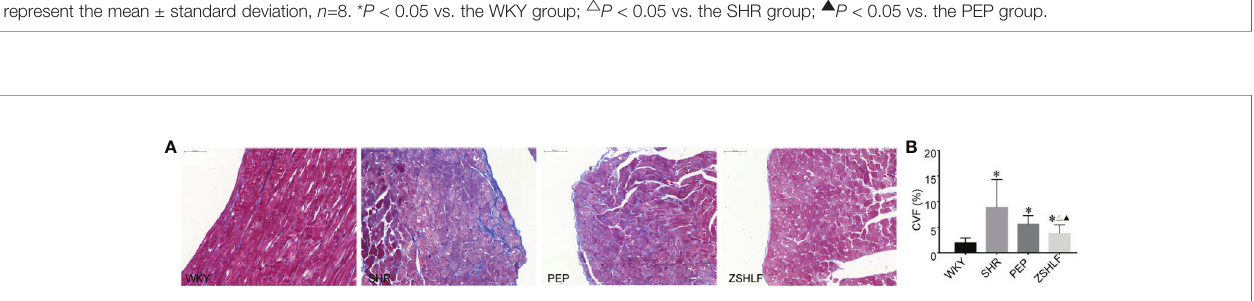
FIGURE 3 | Effects of Zi Shen Huo Luo Formula (ZSHLF) on hemodynamic parameters in spontaneously hypertensive rat (SHRs). (A) Left ventricular hypertrophy (LVSP) of each group. (B) Left ventricular end diastolic pressure (LVDP) of each group. (C) +dp/dtmax of each group. (D) − dp/dtmax of each group. The data represent the mean ± standard deviation, n =8. * P < 0.05 vs. the WKY group; △ P < 0.05 vs. the SHR group; ▲ P < 0.05 vs. the PEP group.